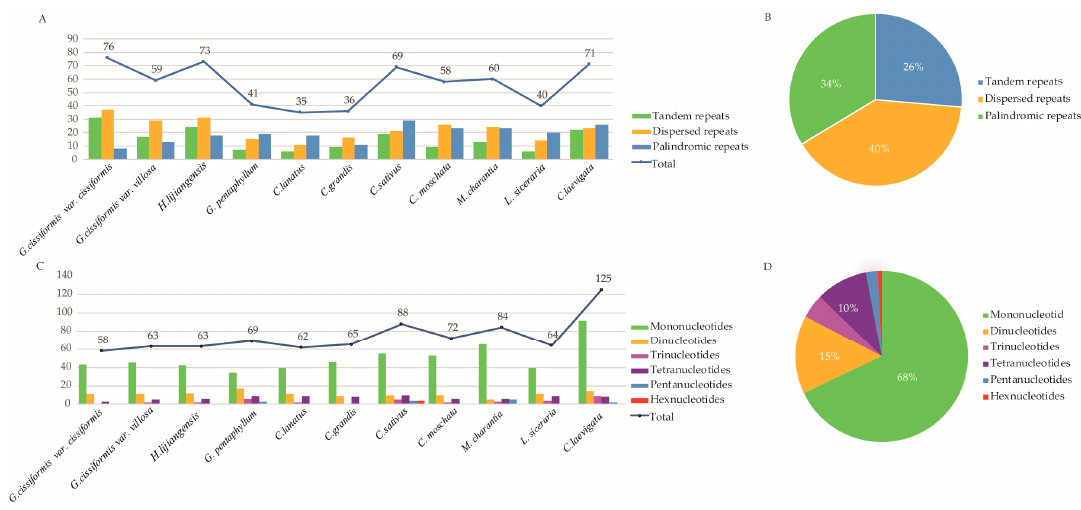
Figure 5. The type and presence of repeated sequences and simple sequence repeats (SSR) in the chloroplast genomes of eleven Cucurbitales species. ( A ) Number of three-types repeats; ( B )Percentage of three repeat types; ( C ) Number of SSRs and their types; ( D ) Percentage of SSR types.